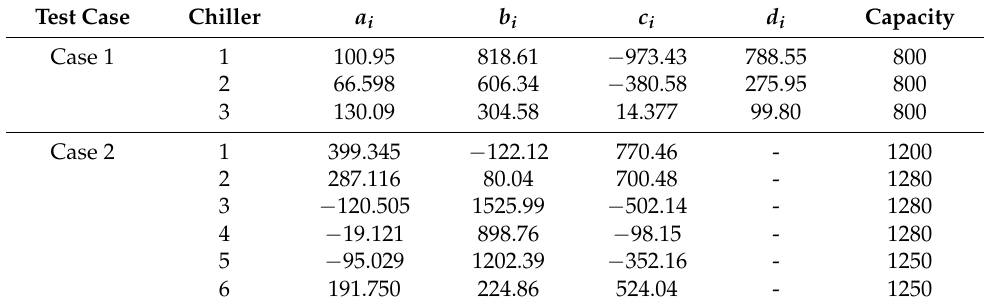
Table 6. Chiller parameters for test